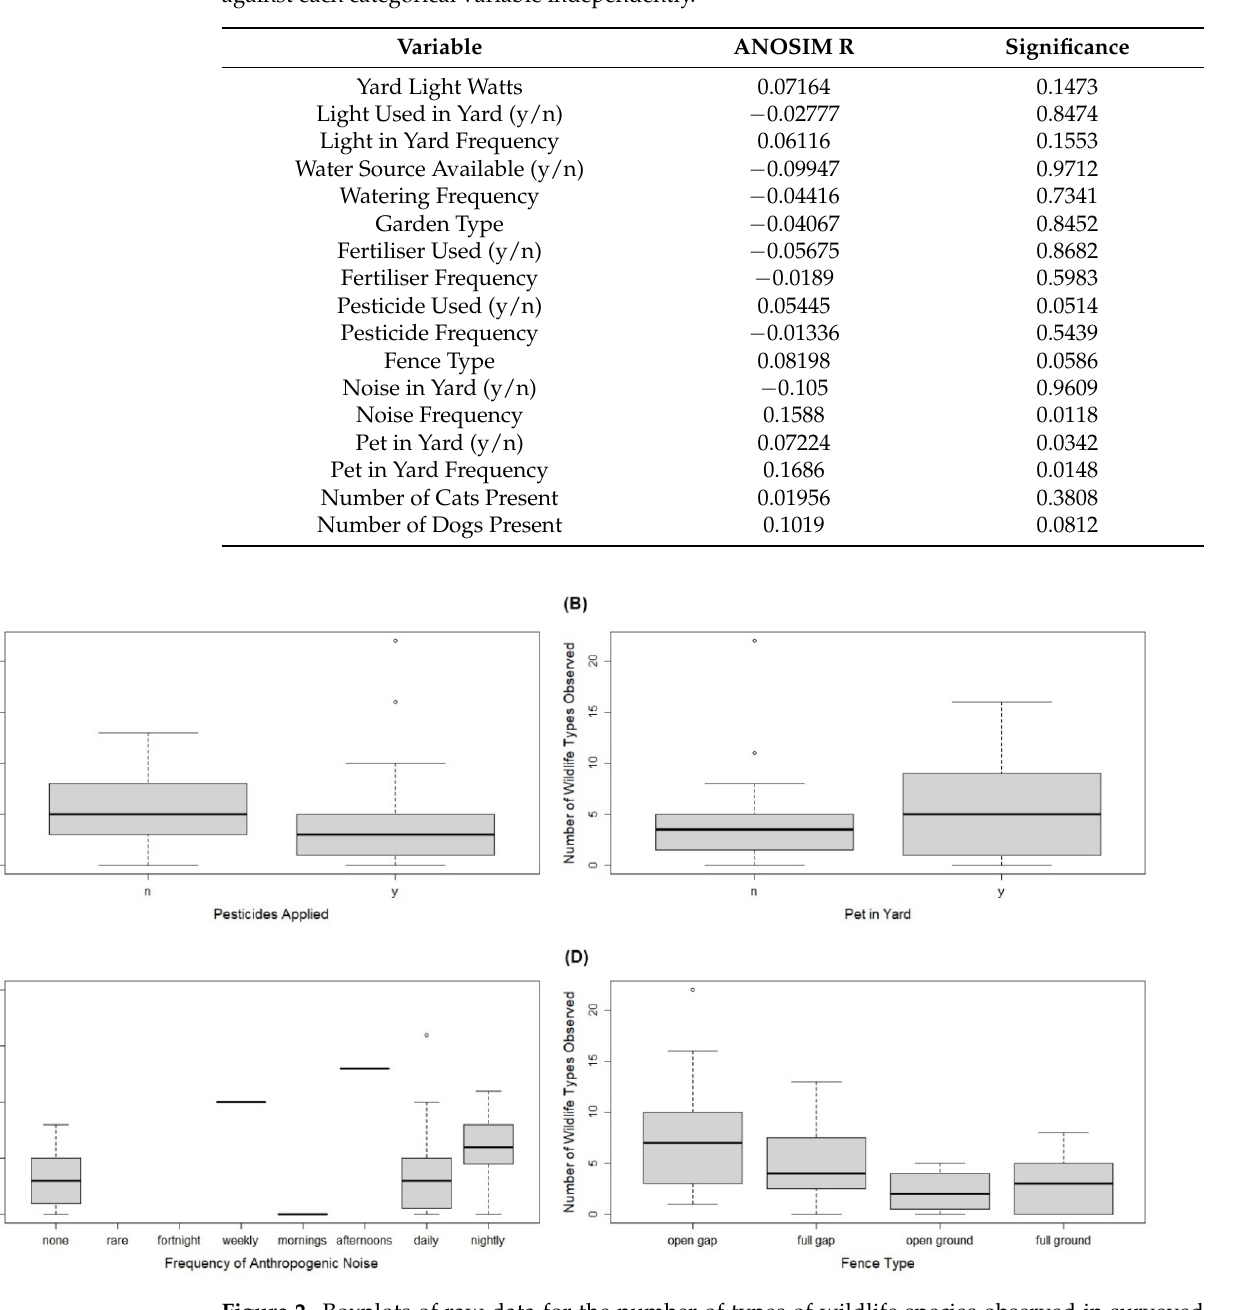
Figure 2. Boxplots of raw data for the number of types of wildlife species observed in surveyed householders’ yards, by ( A ) pesticides applied, ( B ) pets in yard, ( C ) frequency of anthropogenic noise heard in yard, and ( D ) fence type ( open or fully enclosed material— full ) relative to access